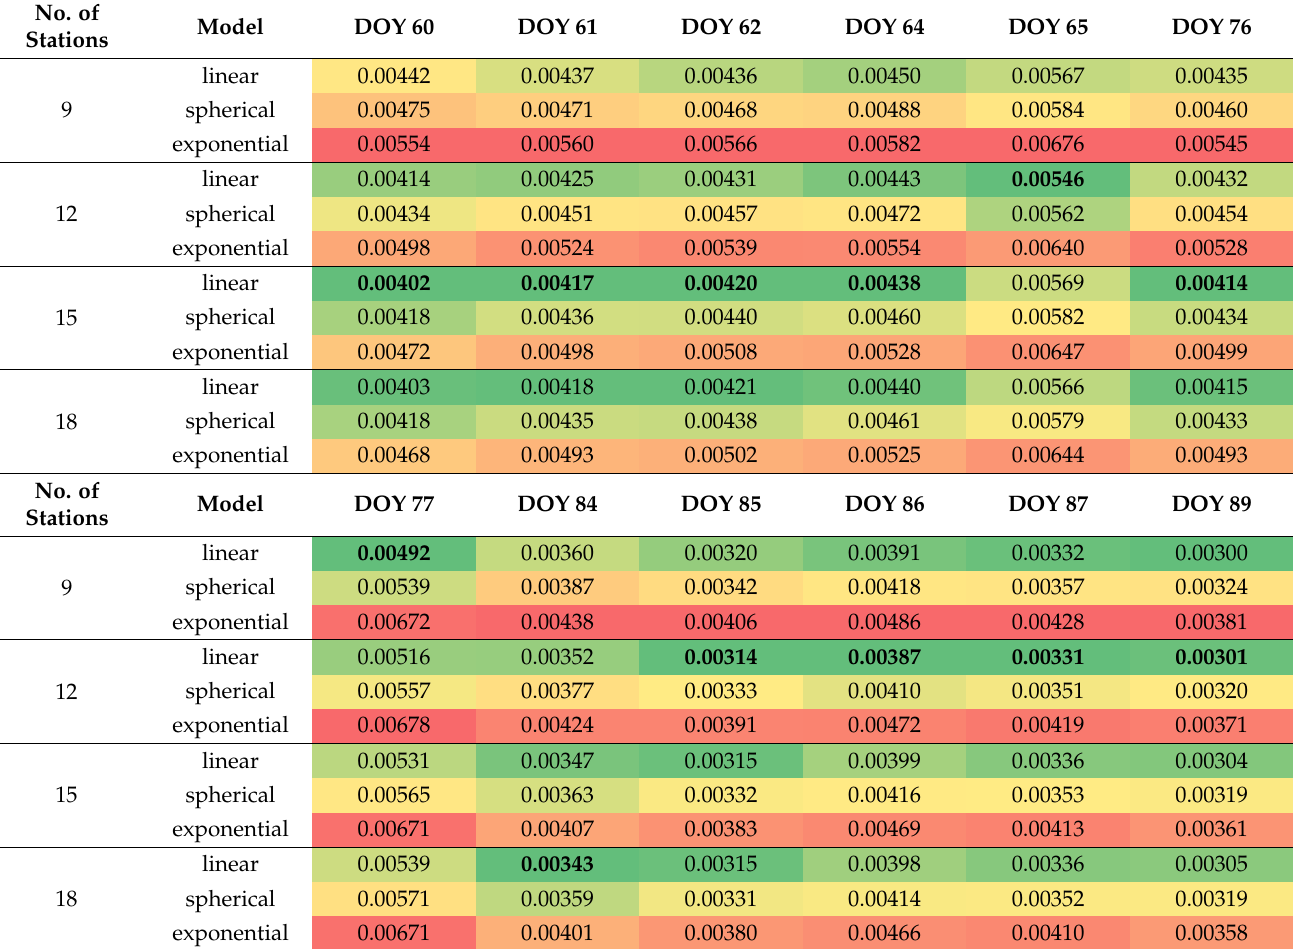
Table 1. Mean normalized error (MNE) values throughout 12 days of March 2015. Values in bold and in green indicate the best-performing parameter set on that day. The worst-performing sets are in